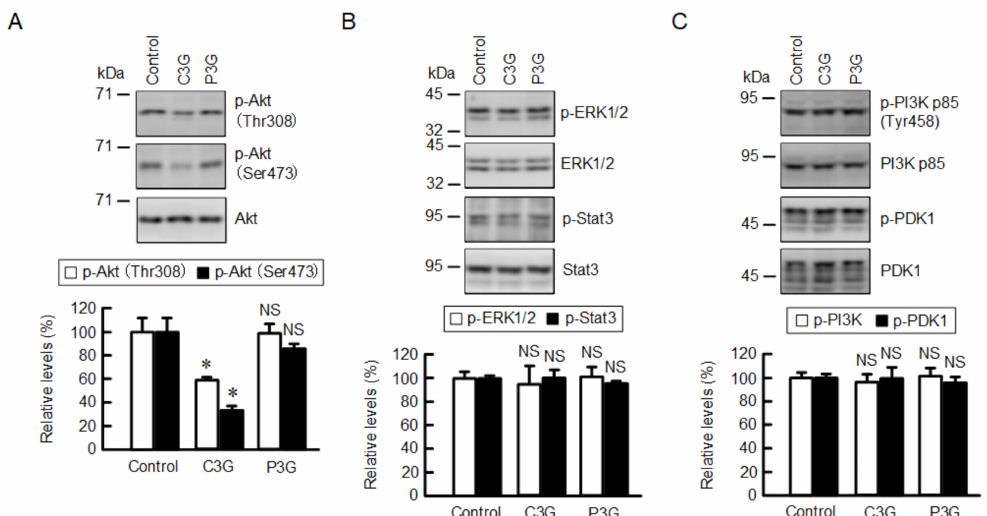
Figure 4. Effects of anthocyanins on intracellular signaling pathways. Cells were incubated in the absence (control) and presence of 50 µ M anthocyanins for 1 h. ( A ) Cell lysates were immunoblotted with anti-p-Akt (Thr308), anti-p-Akt (ser473), and anti-Akt antibodies. ( B ) Cell lysates were immunoblotted with anti-p-ERK1/2, anti-ERK1/2, anti-p-Stat3, and anti-Stat3 antibodies. ( C ) Cell lysates were immunoblotted with anti-p-PI3K p85 (Tyr458), and anti-p-PI3K p85, anti-p-PDK1, and anti-PDK1 antibodies. The protein levels were represented as a percentage relative to control. n = 4. * p < 0.05 and NS p > 0.05 compared with